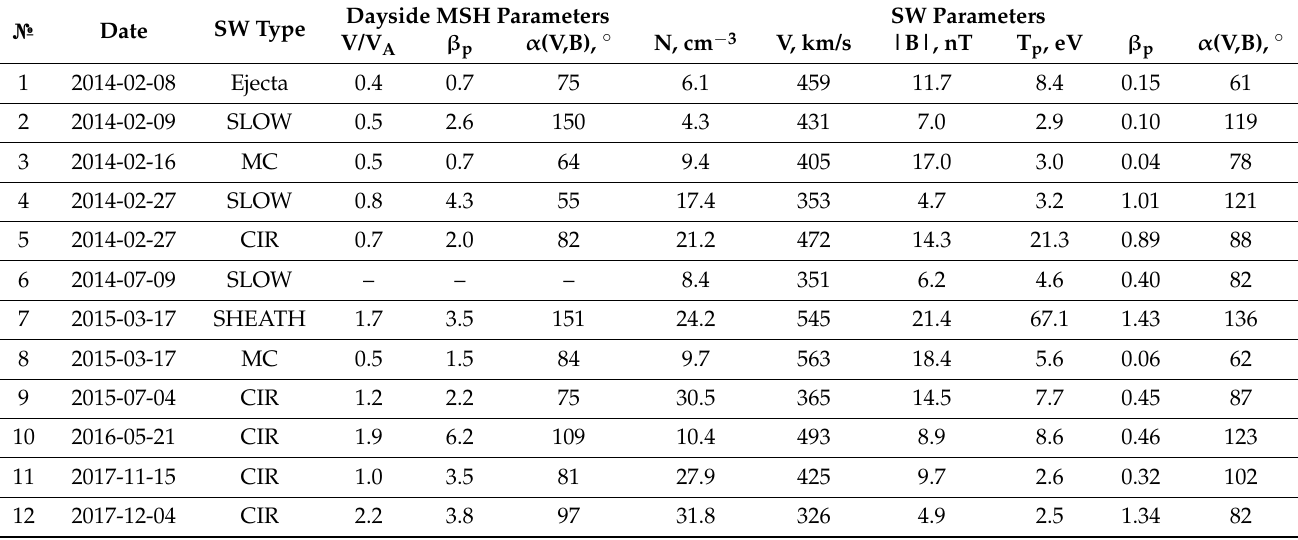
Table 1. Characteristic background parameters of the analyzed